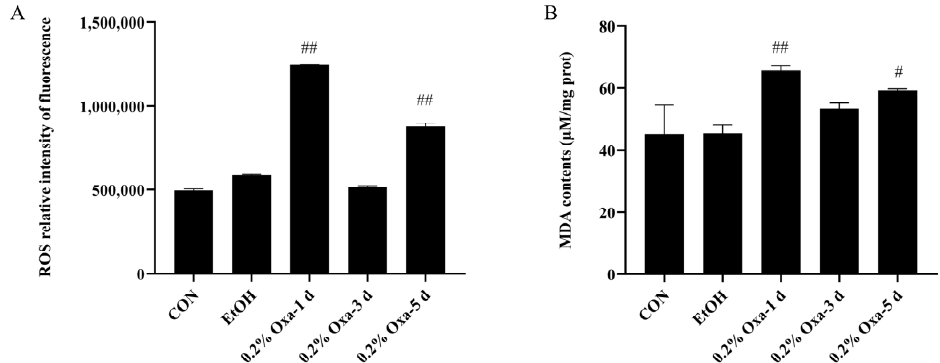
Figure 1. Changes in ROS content and MDA content caused by oxazolone injection time. The values are expressed as the mean ± SD. (n = 6 per group). Statistical differences between groups during the indicated time course were obtained according to repeated-measurement ANOVA (compared with the CON group, # p < 0.05, ## p < 0.01).